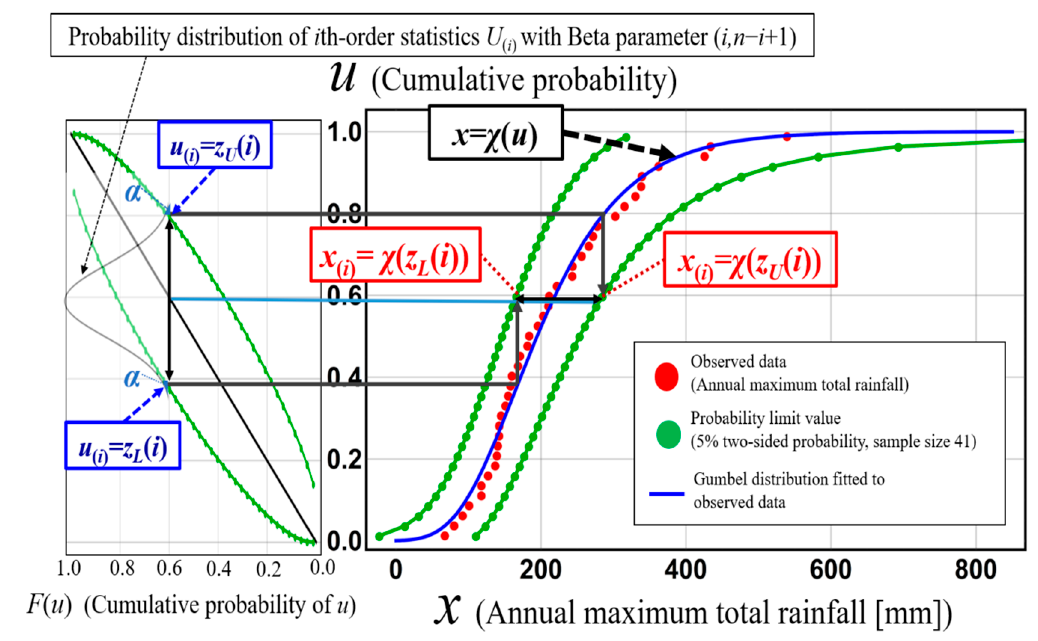
Figure 7. Construction process of probability limit line for probability limit method test for an assumed probability distribution in the case of 5% two-sided probability and sample size 41.